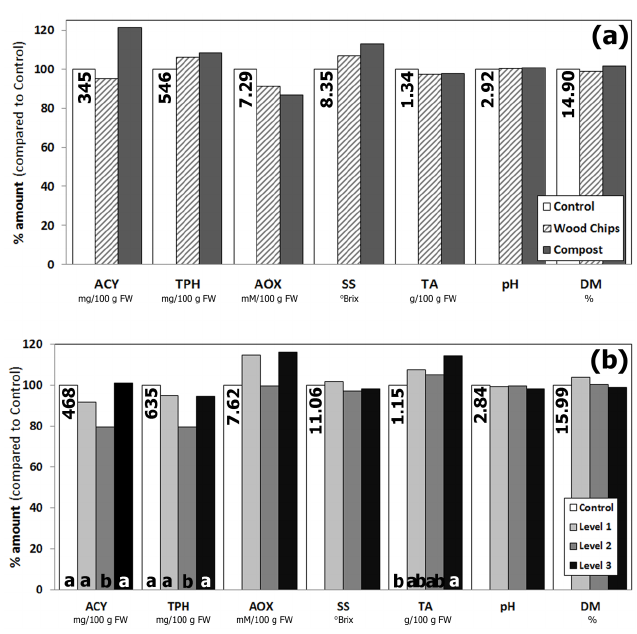
Fig. 2: Quality parameters (mean values from 2009 to 2011) in bilberries upon fertilization. (a) Organic fertilization (wood chips and com- post) at trial fields F1/F2 (Sørdalen) in Northern Norway. (b) Min- eral fertilization at trial field F5 (Snåsa) in Mid Norway: Control – 0 kg N/ha; Level 1 – 30 kg N and 20 kg P/ha; Level 2 – 30 kg N and 40 kg P/ha; and Level 3 – 60 kg N and 40 kg P/ha. Letters indicate significant differences ( P < 0.05) between treatments, based on cor- responding measurements (replicate data from all trial years).